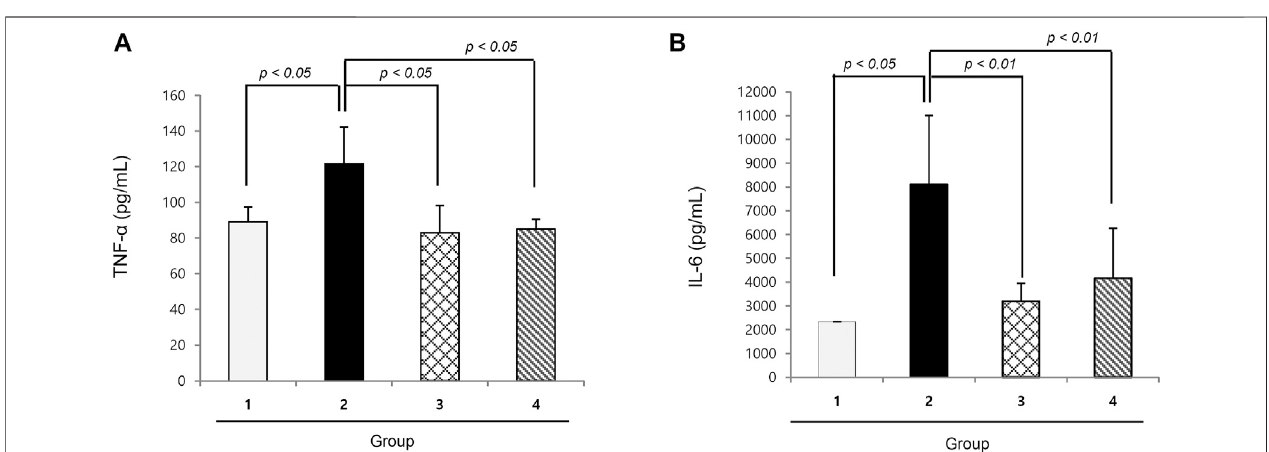
FIGURE2 | Mean sera levels ofcachexic cytokines, TNF- α and IL-6 according tothe groups (A) TNF- α and (B) IL-6. TNF- α and IL-6 were signi fi cantlyincreased in Group 2, cancer cachexia group. Their levels were signi fi cantly decreased in the group treated with NR